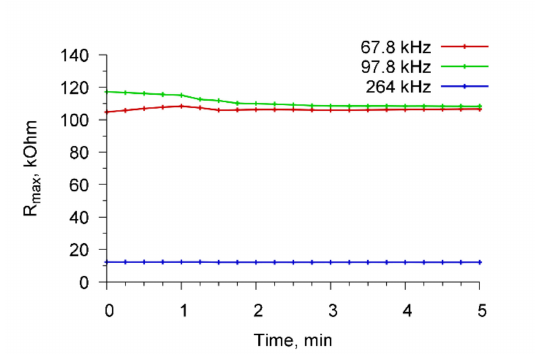
Figure 8. The time dependencies of the maximum of the real part of the electrical impedance of PZT resonator at addition of Abs specific to A. brasilense Sp7 to distilled water without cells for resonance peaks near the frequencies 68.7, 97.8, and 264 kHz.